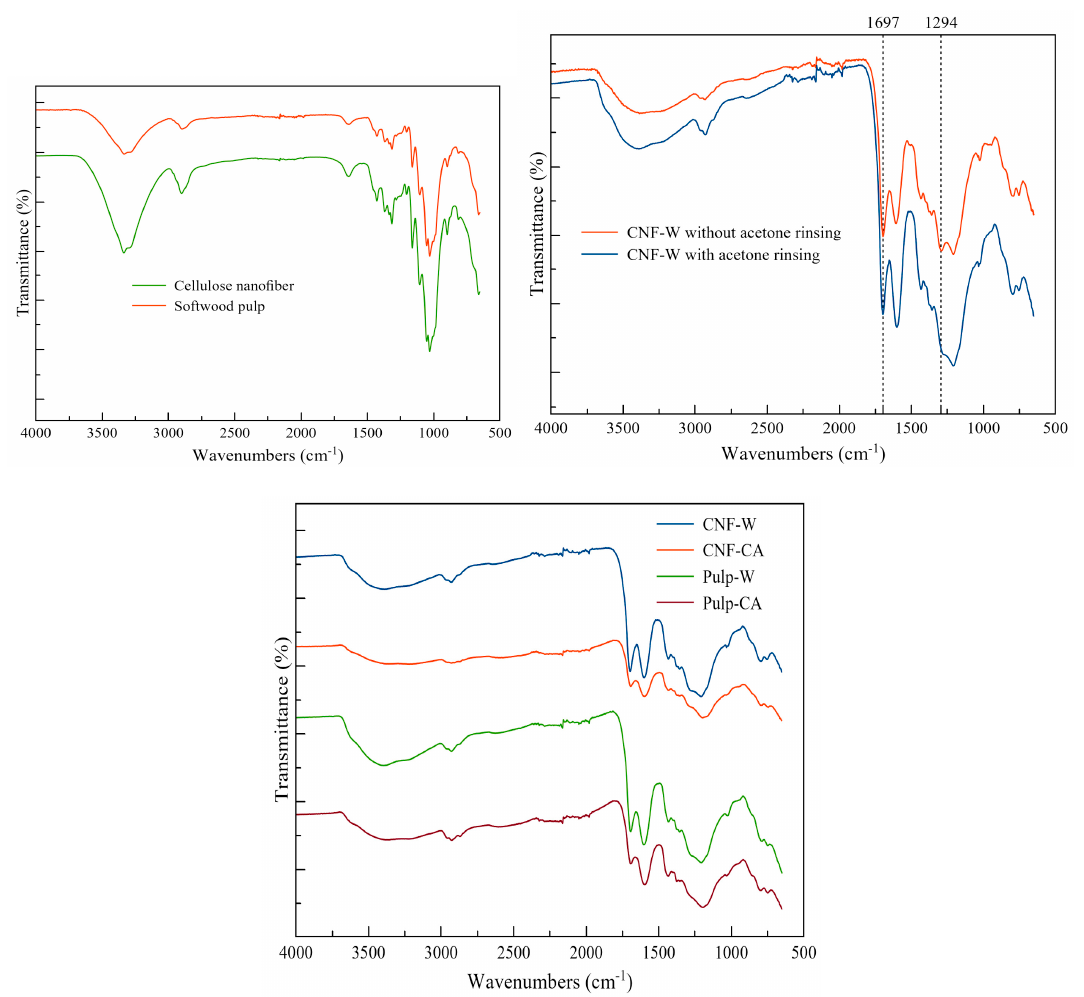
Figure 5. ATR-FTIR spectra of feedstocks and hydrochars.